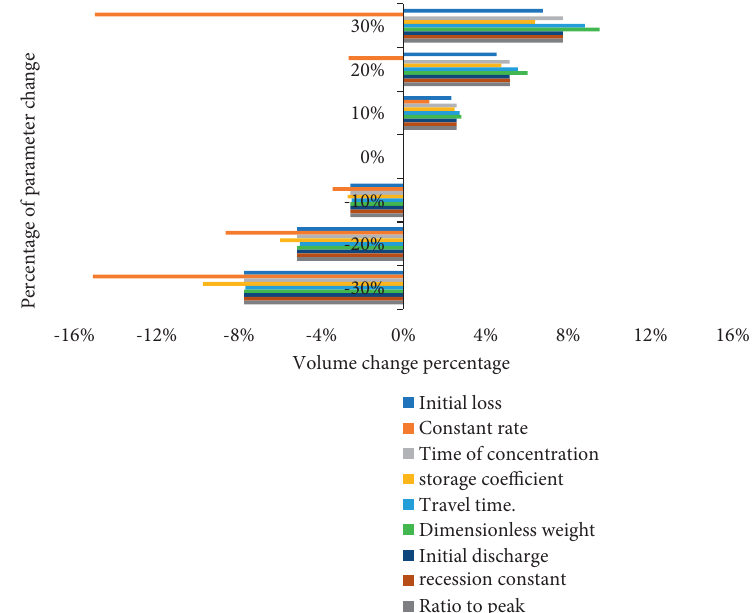
Figure 15: Percentage change in volume verses percentage of parameter